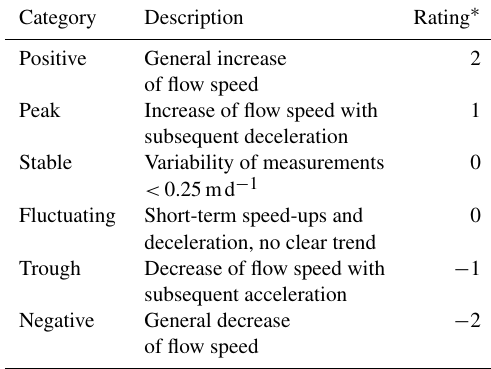
Table 3. Description of velocity change categories.